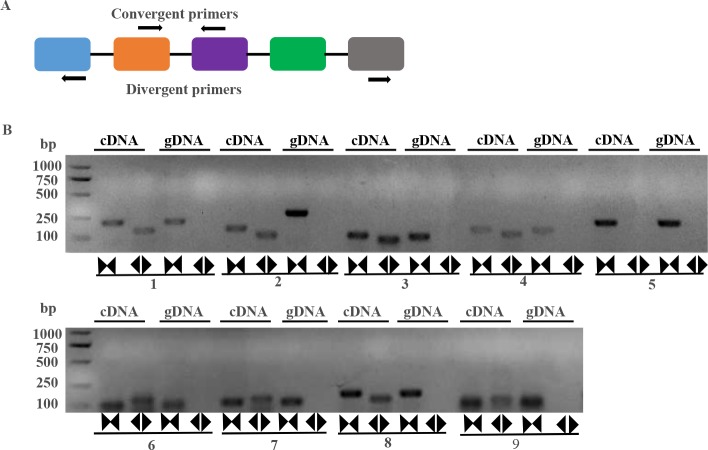
Validation of maize circRNAs.Validation of circular RNAs (circRNAs) by PCR amplifications with divergent primers in maize. (A) Divergent and convergent primers for amplification of circRNA and linear RNA are shown in a model, respectively. (B) A set of divergent primers (black back-to-back triangle pairs) successfully amplified eight circRNAs in cDNA. A set of convergent primers (black opposing triangle pairs) could work on both cDNA and genomic DNA. Note: 1: seedling_test_circ_000962, 2: seedling_test_circ_001425, 3: seedling_test_ circ_000119, 4: seedlingd_test_circ_002114, 5: Actin, 6: seedlingc_test_circ_000623, 7: seedlingd_ test_circ_000813, 8: seedling_test_circ_001637, 9: control_test_circ_004099.